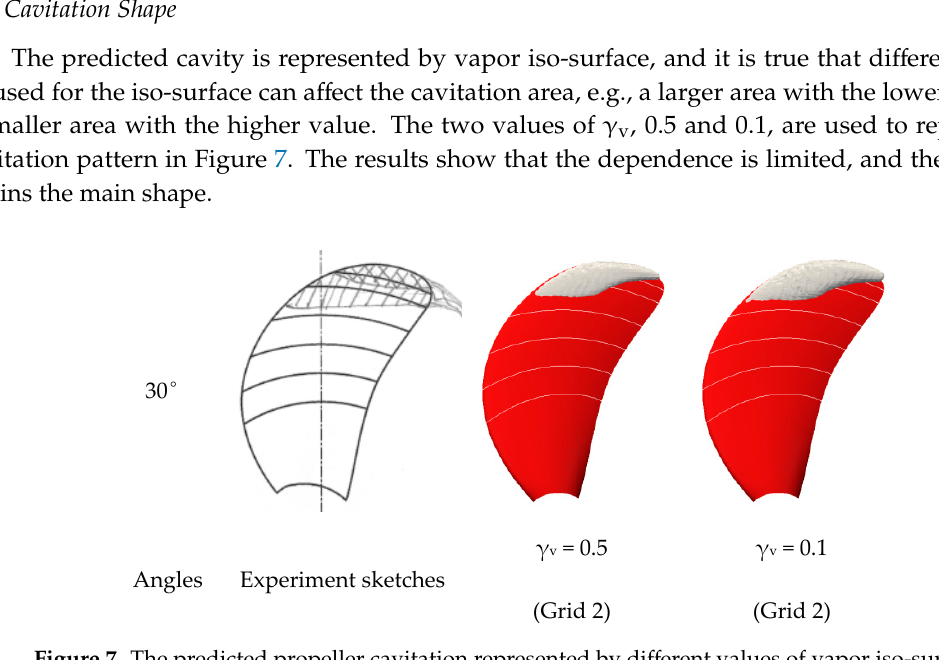
Figure 7. The predicted propeller cavitation represented by different values of vapor iso-surface.